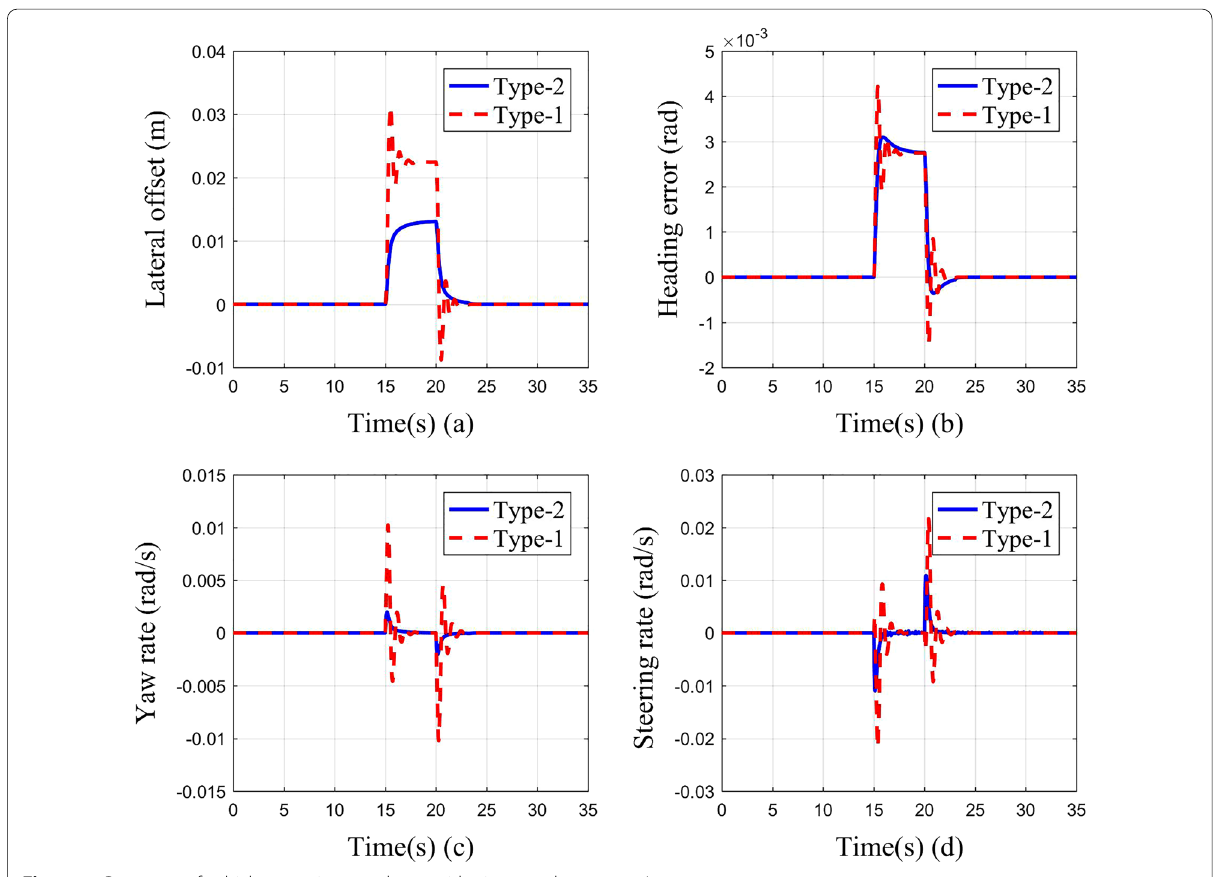
Figure 4 Response of vehicle states in accordance with given road curvature-I